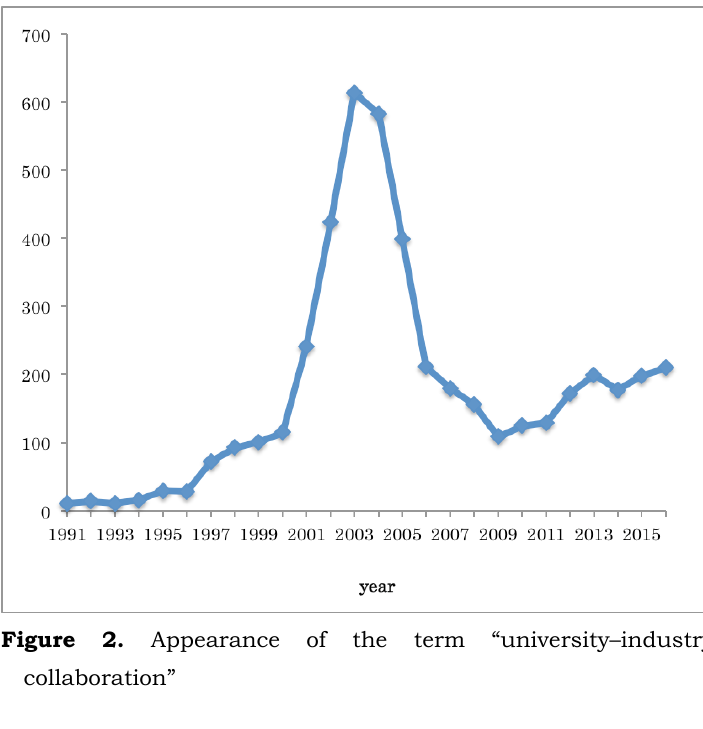
Figure 2. Appearance of the